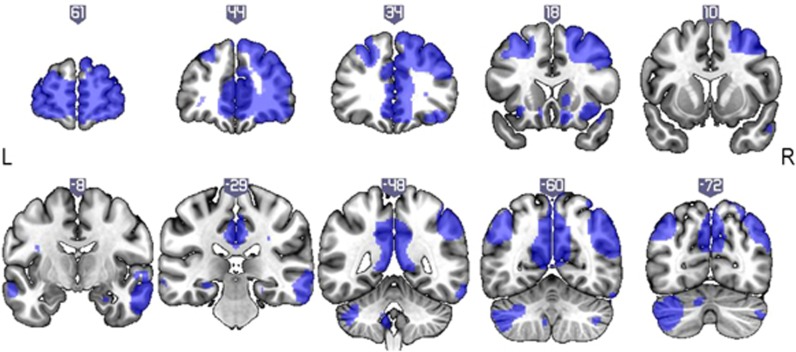
Frontal polar cortex connectivity. A frontal polar cortex (FPC) seed was correlated with the whole brain to produce seed-to-voxel functional connectivity maps. The connectivity map is displayed at p=0.001 uncorrected for illustration.